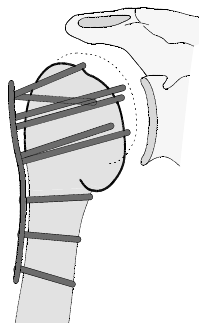
Figure 15. Complication Type 2c. Pattern image. Severe varus displacement and instability of the humeral head after angle-stable plate osteosynthesis is shown by the transition of the dashed drawing (initially correct humeral head position) to the prominent black drawing. This is followed by a cutout of four screws.